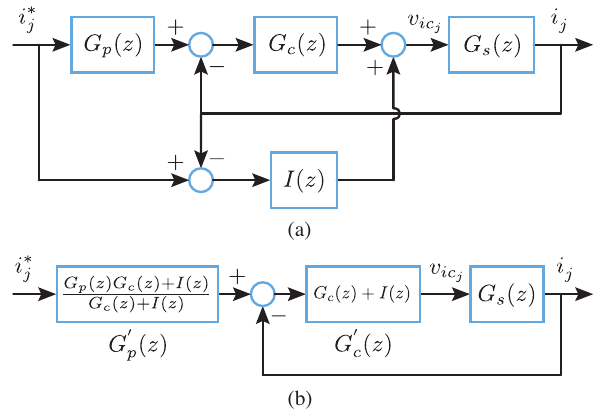
Figure 8. Proposed IPCC control: ( a ) block diagram; and ( b ) simplified block diagram in a prefilter G (cid:48) p ( z ) and compensator G (cid:48) c ( z ) form ( j = { d , q } ).